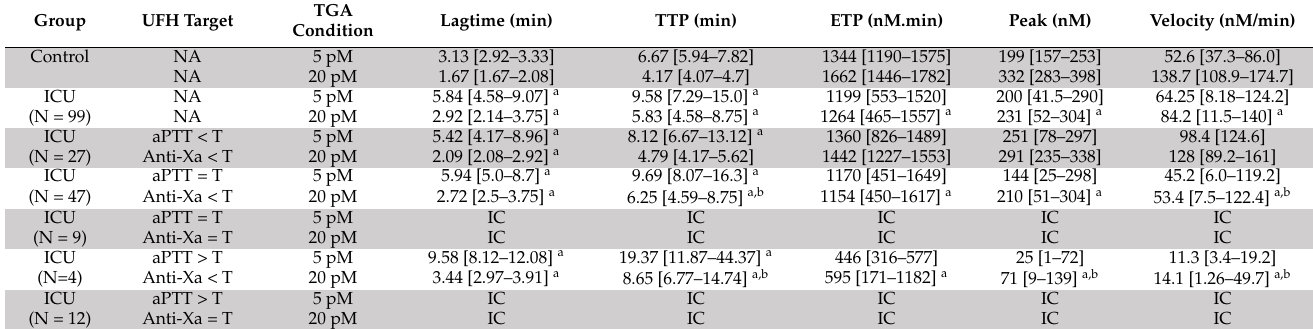
Table 3. Thrombin generation in anticoagulated patients. TGA condition: Tissue factor